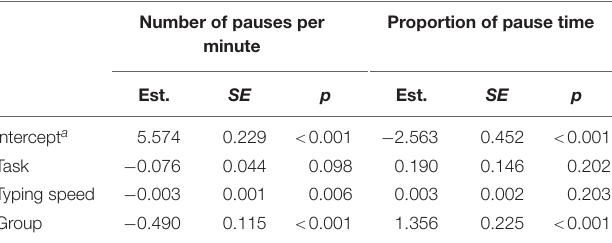
TABLE 8 | Estimates of fixed effects for effects of task, typing speed and group on number of pauses per minute and proportion of pause